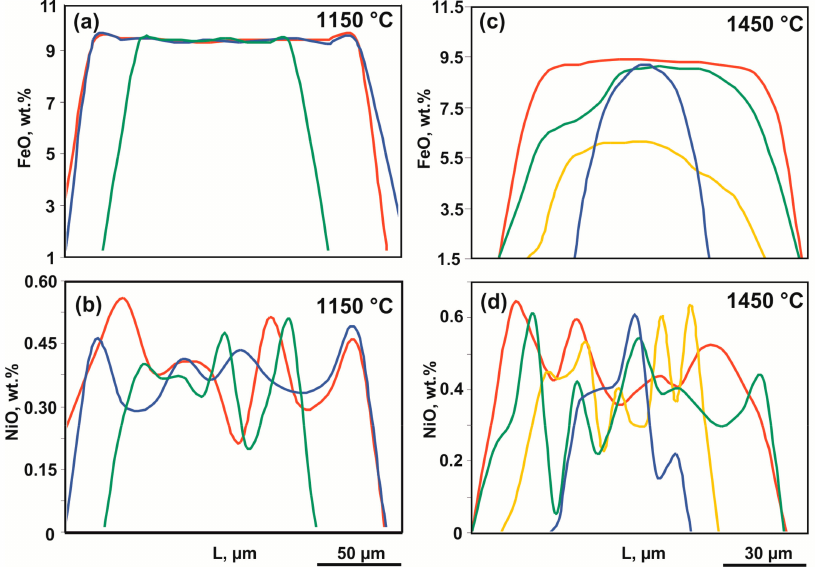
Figure 8. Representative profiles of the FeO and NiO distribution in recrystallized olivine (olivine-ankerite-pyrite system): ( a , b )—1150 ◦ C; ( c , d )—1350 ◦